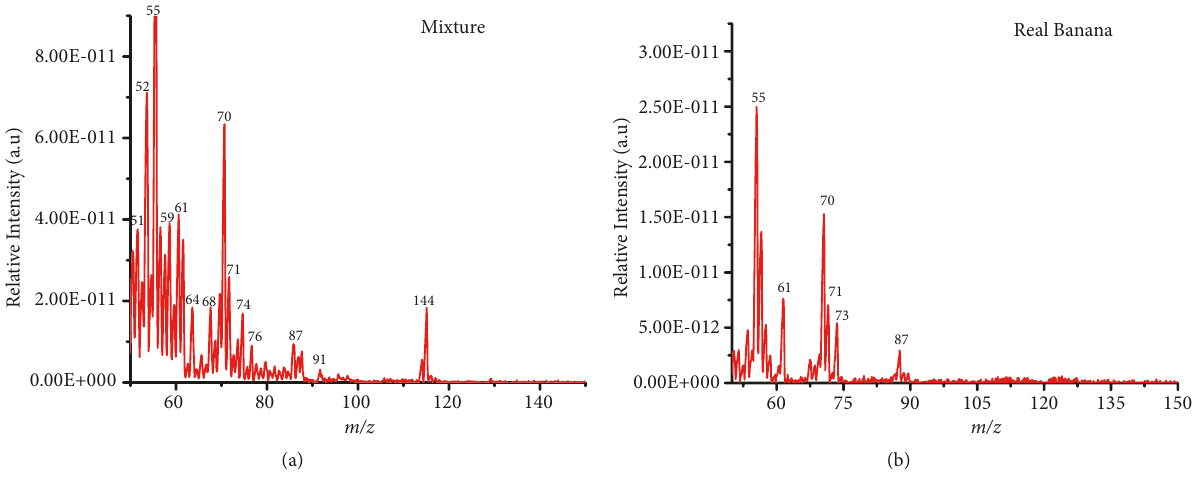
Figure 4: In-situ analysis of standard model compounds in an artificial; (a) mixture of equal volumes of 10 ppm of methylbutyl acetate, 2-mehtyl-3-furanthiol, methyl butanoate, and ethyl methyl sulfide 10 ppm (v/v) using a direct membrane probe coupled to a portable mass spectrometer. Approx. 5 𝜇 L of the mixture was deposited in the flask and left for 2 hours. The headspace vapor of the mixture was detected using a portable mass spectrometercoupled to a direct membraneprobe and (b) shows the mass spectrumof the real banana headspace vapor measured using DIM probe with a portable mass